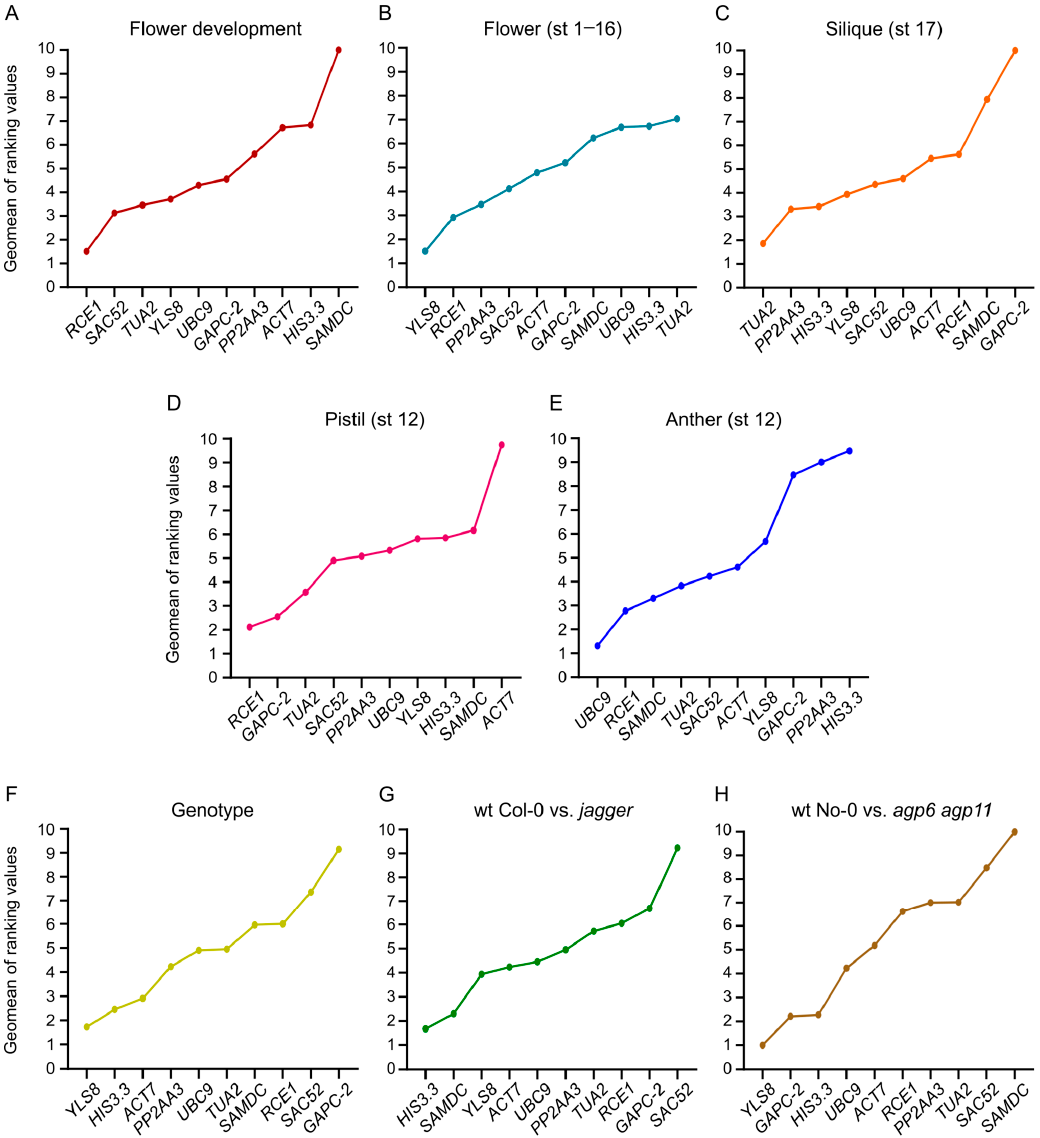
Figure 7. Comprehensive ranking values of the candidate reference genes obtained from geNorm, NormFinder, BestKeeper and Δ Ct. ( A ) Ranking values of the ten candidate reference genes in the flower development group which included 21 samples corresponding to flower (st 1–16), silique (st 17), pistil (st 12), and anther (st 12) samples. ( B ) Ranking values of the ten candidate reference genes in 12 flower (st 1–16) samples which included flower st 1-6, flower st 7–12, flower st 13–14 and flower st 15–16 samples. ( C ) Ranking values of the ten candidate reference genes in the three silique (st 17) samples. ( D ) Ranking values of the ten candidate reference genes in thethree pistil (st 12) samples. ( E ) Ranking values of the ten candidate reference genes in the three anther (st 12) samples. ( F ) Ranking values of ten candidate reference genes in the genotype set that comprised 12 samples corresponding to wt Col-0, jagger , wt No-0 and agp6 agp11 samples. ( G ) Ranking values of the ten candidate reference genes in six wt Col-0 vs. jagger samples that included three wt Col-0 and three jagger samples. ( H ) Ranking values of the ten candidate reference genes in six wt No-0 vs. agp6 agp11 samples which included three wt No-0 and three agp6 agp11 samples. The genes are arranged from the most to the least stable gene (from left to right). Abbreviations: Col-0, Columbia-0; No-0, Nossen-0; st, stage; wt,